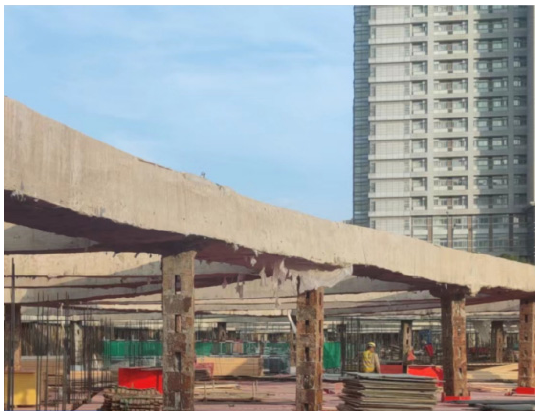
Figure 4. Ring brace.